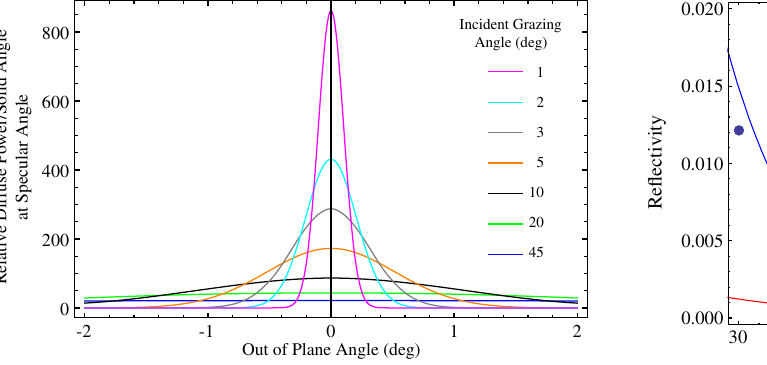
FIG. 10. Comparison of data [18] and model for diffuse scattering at 45° from a rough ( σ ¼ 200 nm) surface layer on an aluminum substrate.